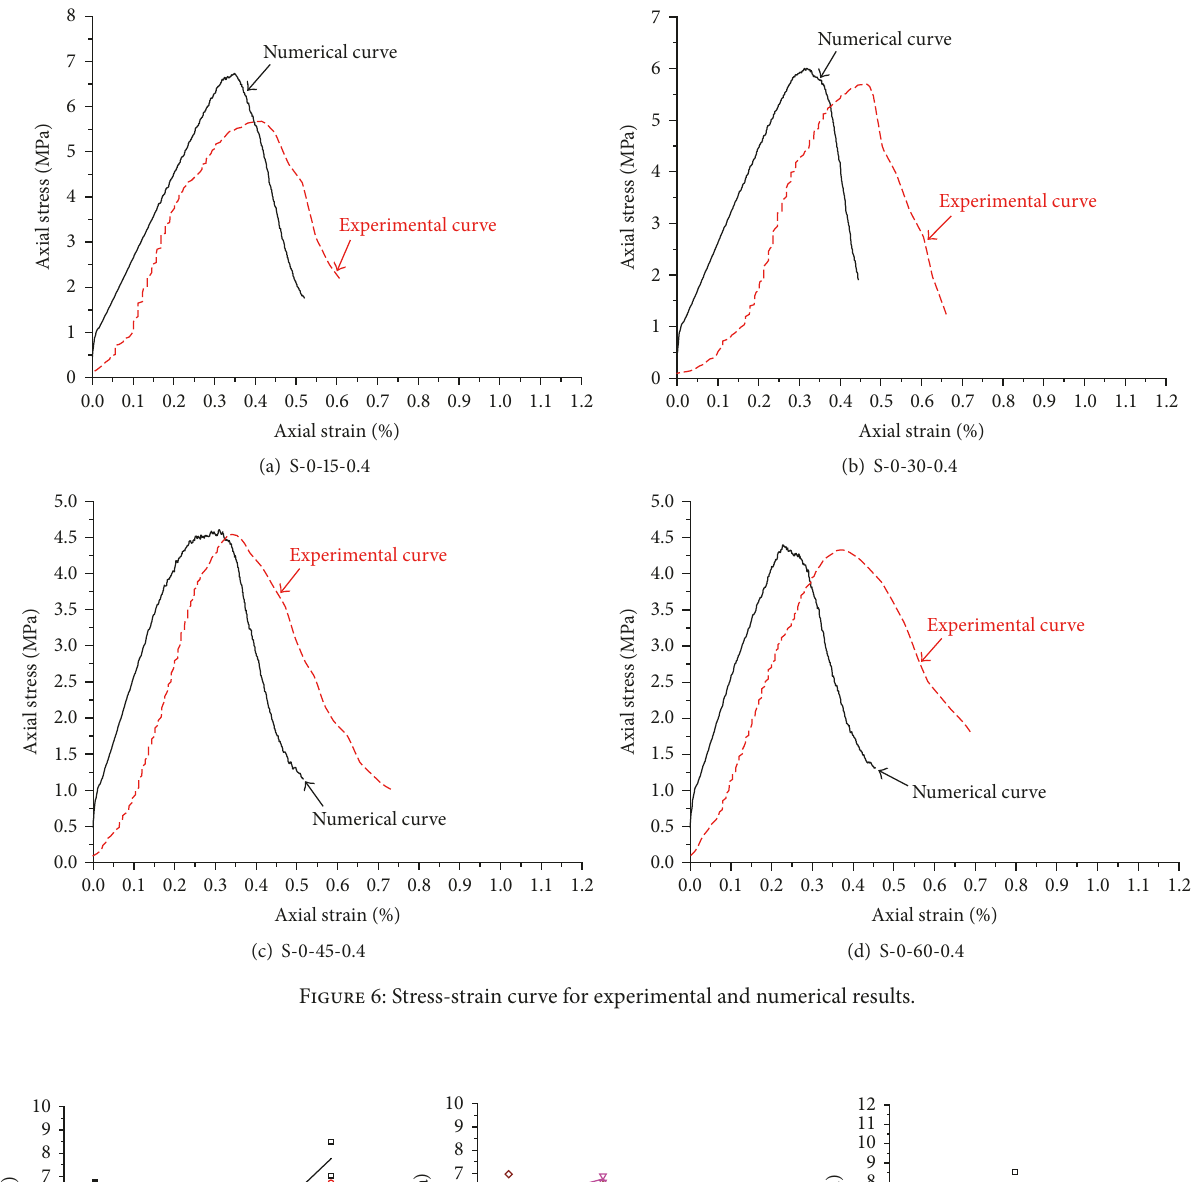
Figure 6: Stress-strain curve for experimental and numerical results.